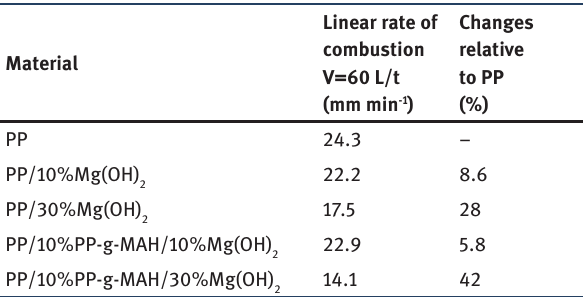
Table 3: Composite linear combustion rates (UL 94